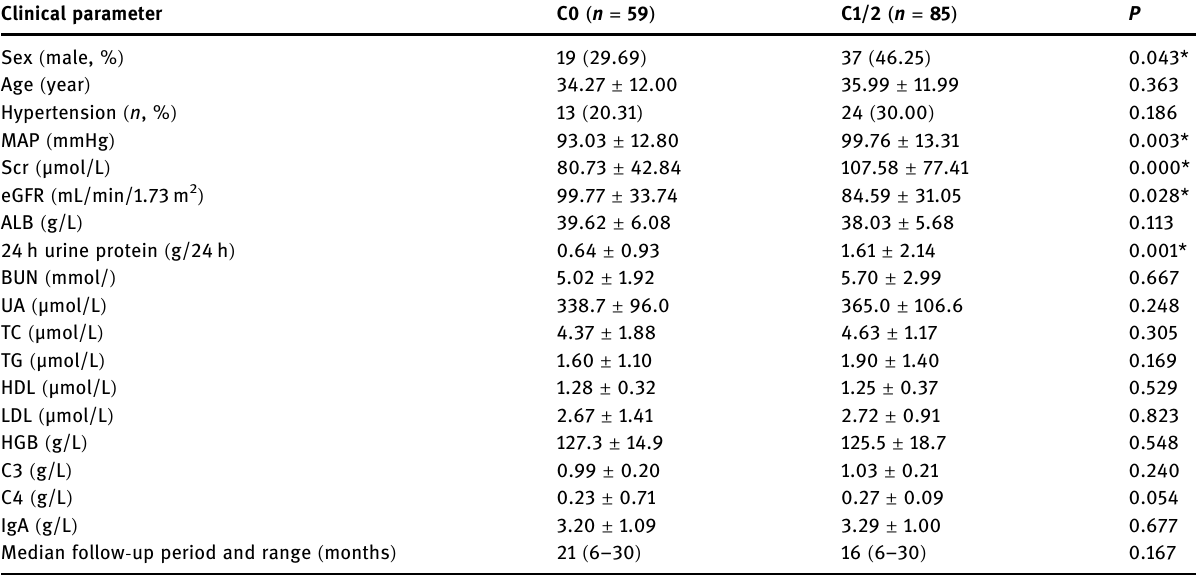
Table 3: Relationship of the C score with clinical parameters of patients with IgAN Clinical parameter